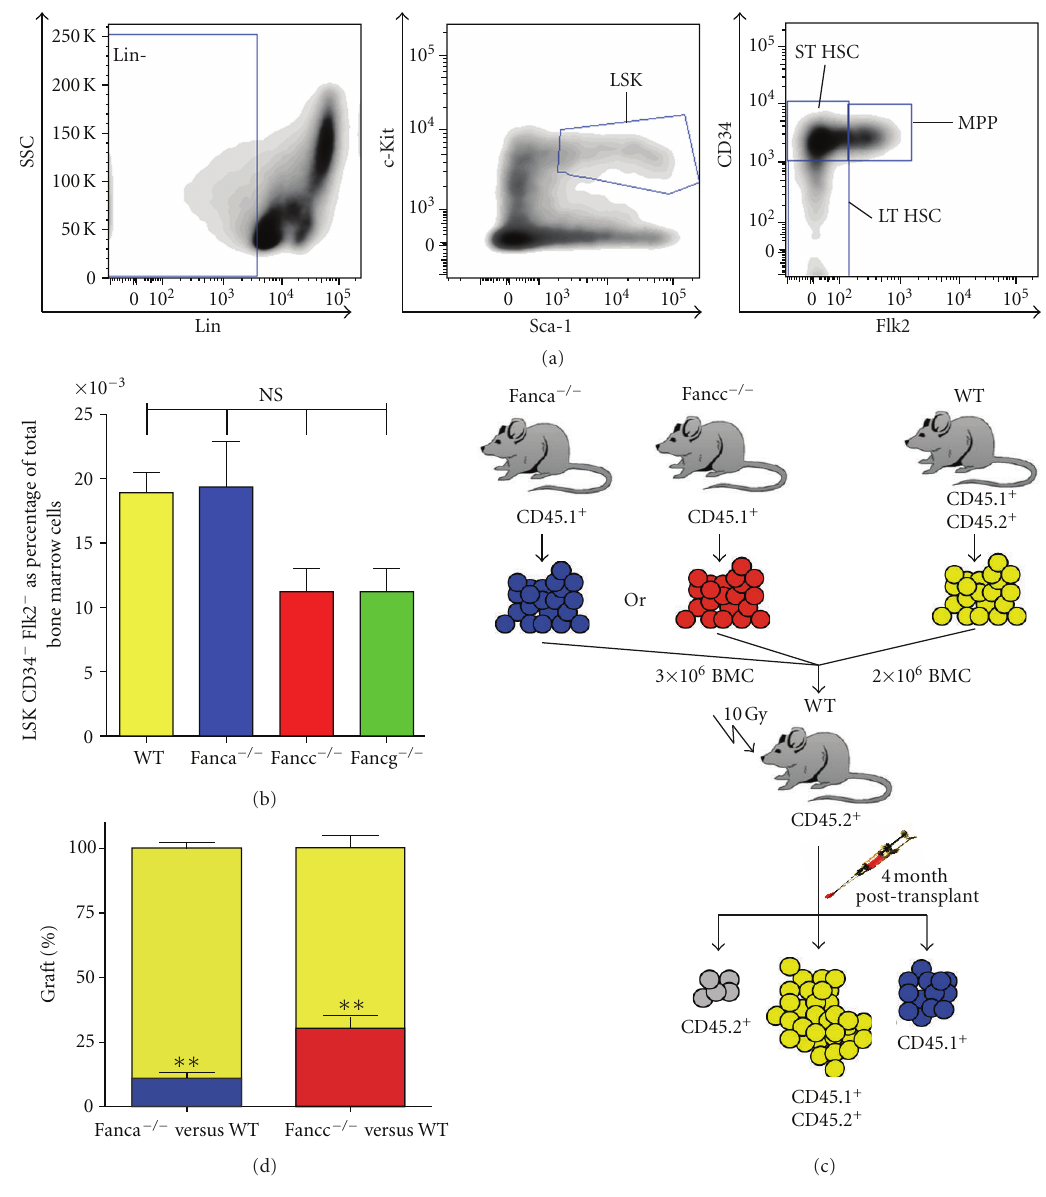
Figure 1: Murine models of FA do not have reduced numbers of immunophenotypically defined HSCs but do have lower frequencies of functionally defined HSCs. (a) Representative FACS plots showing the gating scheme which is employed to enumerate long-term HSCs (LT-HSC) in the BM which are defined by the following combination of immunophenotypic markers: Lineage-, c-Kit+, Sca-1+, Flk2 − , and CD34 − . For illustrative purposes, the compartments enriched for short-term HSC (ST-HSC) and multipotent progenitors (MPP) are also shown. (b) Based on the FACS methodology shown in (a), the frequency of LT-HSCs does not di ff er significantly in wild-type (WT) mice compared to FA mice. The mean frequency of immunophenotypically defined LT-HSC found in the BM of WT ( n = 21), Fanca − / − ( n = 12), Fancc − / − ( n = 6), and Fancg − / − ( n = 6) mice is shown, ± SEM. NS = P > 0 . 05 by comparison using ANOVA. (c) Schematic representation of the competitive repopulation assay employed to assess the relative frequency of HSCs in WT versus either Fanca − / − or Fancc − / − mice. BM from FA (3 × 10 6 total BM cells) and WT (2 × 10 6 total BM cells) mice were coinjected into lethally irradiated (10Gy total body irradiation) recipient mice at a 3:2 ratio, respectively. At four months posttransplant, peripheral blood was harvested from recipient mice and the percentage contribution of FA cells to the peripheral blood was determined by FACS analysis, taking advantage of the di ff erential expression of CD45 subtypes on the surface of FA (CD45.1+ and CD45.2 − ) and WT (CD45.1+ and CD45.2+) leukocytes. If FA BM contained the same number of functionally defined HSCs as WT BM, then the FA HSCs would be predicted to contribute to 60% of the peripheral blood chimerism at 4 months posttransplant. (d) FA HSCs have a severe engraftment defect compared to WT HSCs. The mean relative frequency that FA or WT cells contributed to peripheral blood leukocyte engraftment at 4 months post-transplantation is shown ± SEM. ∗∗ = P < 0 . 001 for comparison of WT versus FA chimerism using ANOVA. n = 21 for WT versus Fanca − / − , and for WT versus Fancc − / − . Fancc − / − , Fancg − / − and Fanca − / − mice have all been previously described